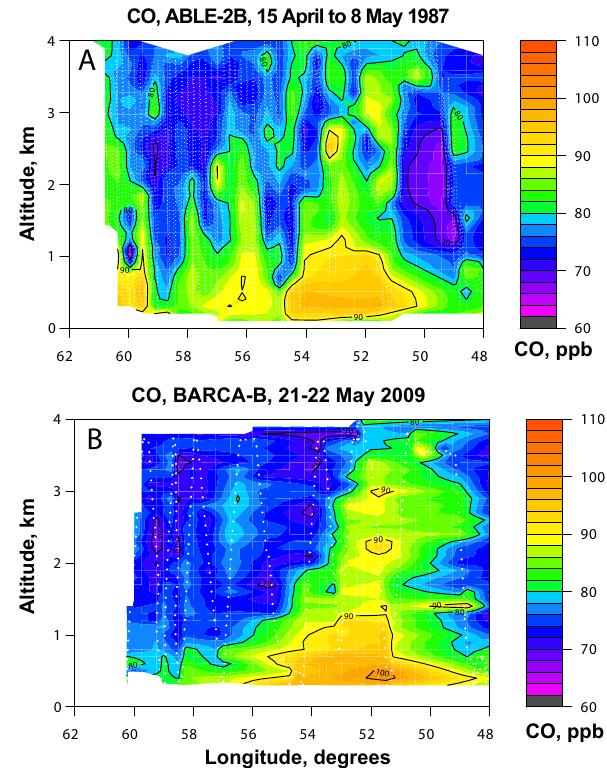
Fig. 9. Cross sections of CO mixing ratios from (A) ABLE-2B (15 April–8 May 1987) and (B) BARCA-B (21–22 May 2009) along the equator ( ± 4 ◦ ). Urban data and a fresh smoke plume were omitted from the data. White dashed lines show flight